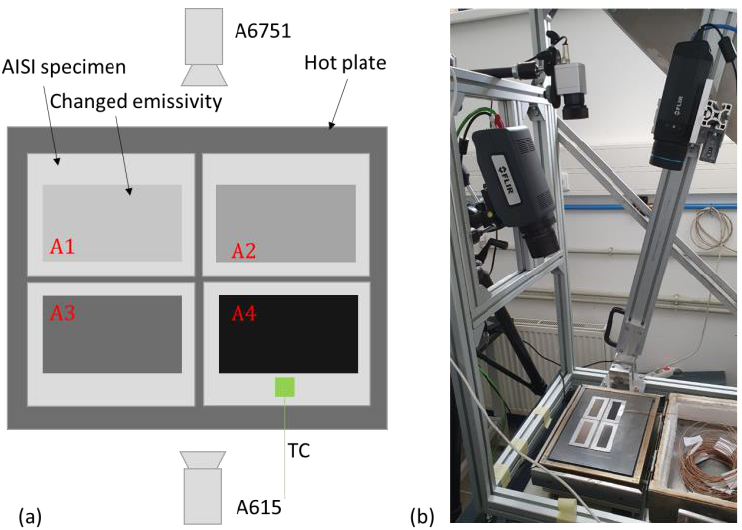
Figure 5. Measurement setup ( a ) scheme, ( b )